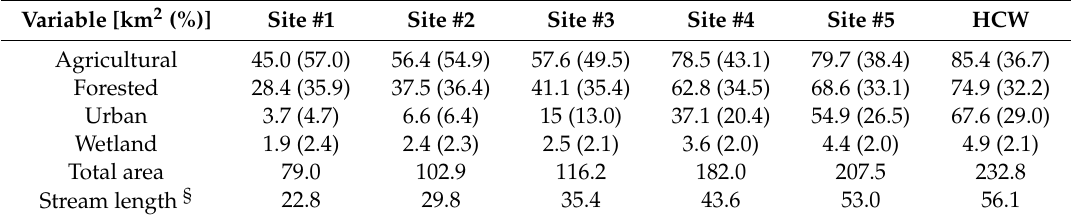
Figure 1. Locations of gauge sites (where #4 includes the USGS gauging station) and corresponding drainage area to each gauge (bold line) in the Hinkson Creek Watershed (HCW), in Central Missouri, USA. A model urban nested-scale experimental watershed study. Table 1. Cumulative land use and land cover (LULC), drainage area, and stream length corresponding to each gauging site located in Hinkson Creek Watershed (HCW), Missouri, USA. Percent cumulative LULC is shown